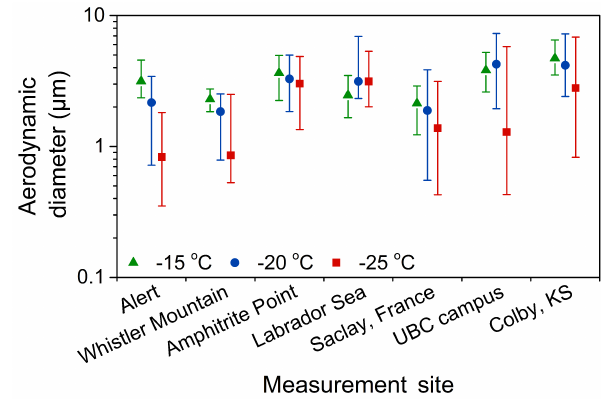
Figure 4. The median size of INPs at ice-activation temperatures of − 15 ◦ C (green), − 20 ◦ C (blue), and − 25 ◦ C (red) when averaged over all analyzed samples. Upper and lower uncertainties are the 75th and 25th percentiles,